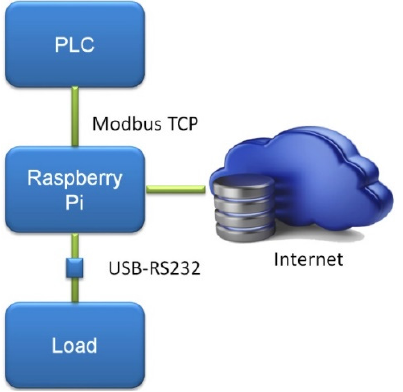
Figure 2. Communications diagram of the I ‐ V curve tracer. Table 2. Magnitudes and sensors used in the curve